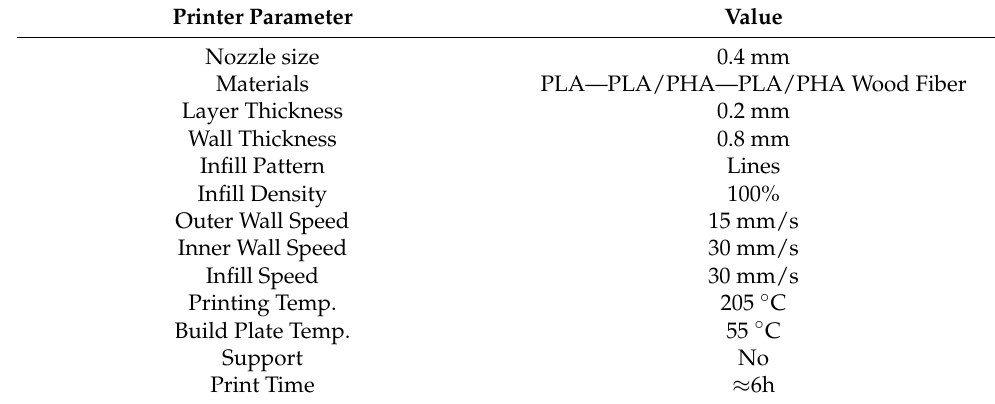
Table 3. Parameters of the FFF process used for fabrication of the Voronoi lattice structure.